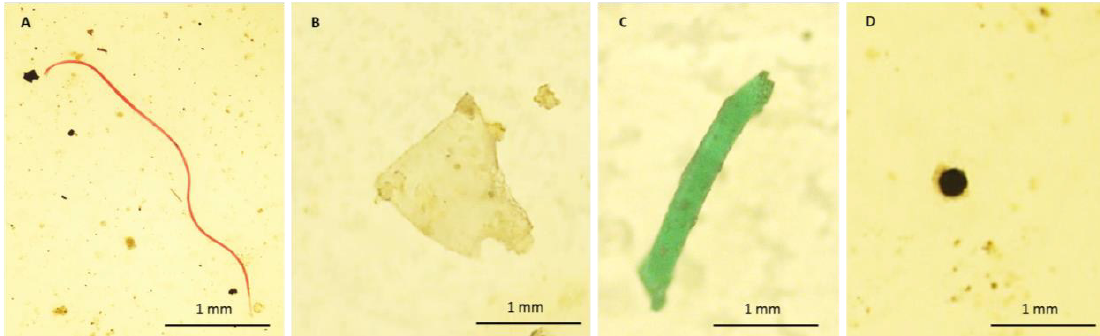
Fig. 2: Microplastics shape found in selected sample, a) fiber, b) film, c) fragment, d) pellet